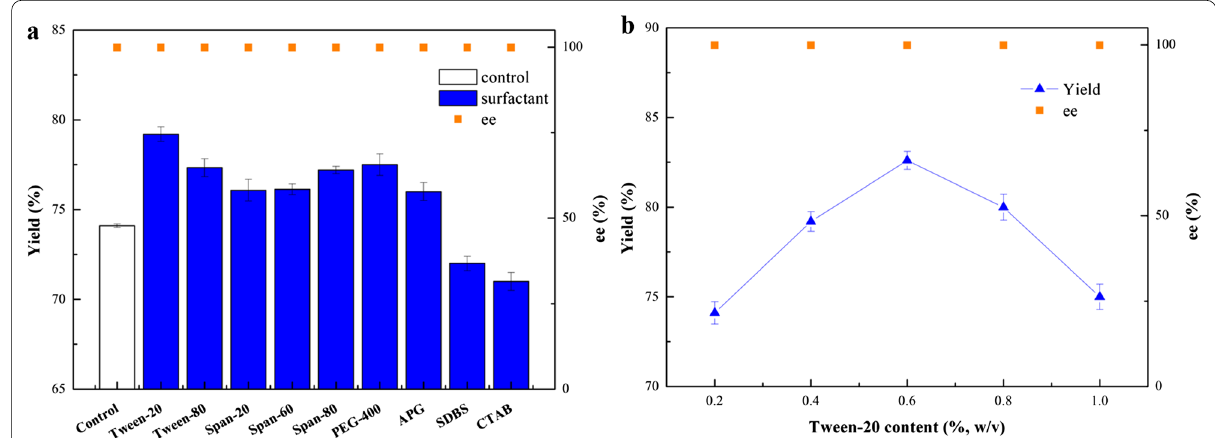
Fig. 3 Effect of different surfactant ( a ), and various Tween-20 content ( b ) on the ( R )-MTF-PEL production with recombinant E. coli cells. Reaction conditions: 200 mM 3’-(trifluoromethyl)acetophenone, 15% (v/v) isopropanol, 17.2 g (DCW)/L recombinant E. coli cells, PBS buffer (pH 7.5) ( a, b ), 0.4% (w/v) various surfactants ( a ), 30 ℃ , 200 rpm, 21